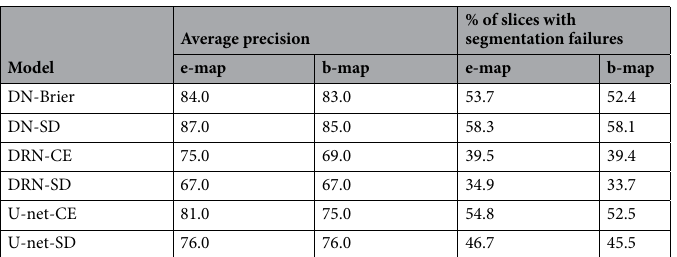
Table 3. Average precision and percentage of slices with segmentation failures generated by Dilated Network (DN), Dilated Residual Network (DRN) and U-net when trained with soft-Dice (SD), CE or Brier loss. Per patient, average precision of detected slices with failure using e- or b-maps (2nd and 3rd columns). Per patient, average percentage of slices containing segmentation failures (reference for detection task) (4th and 5th